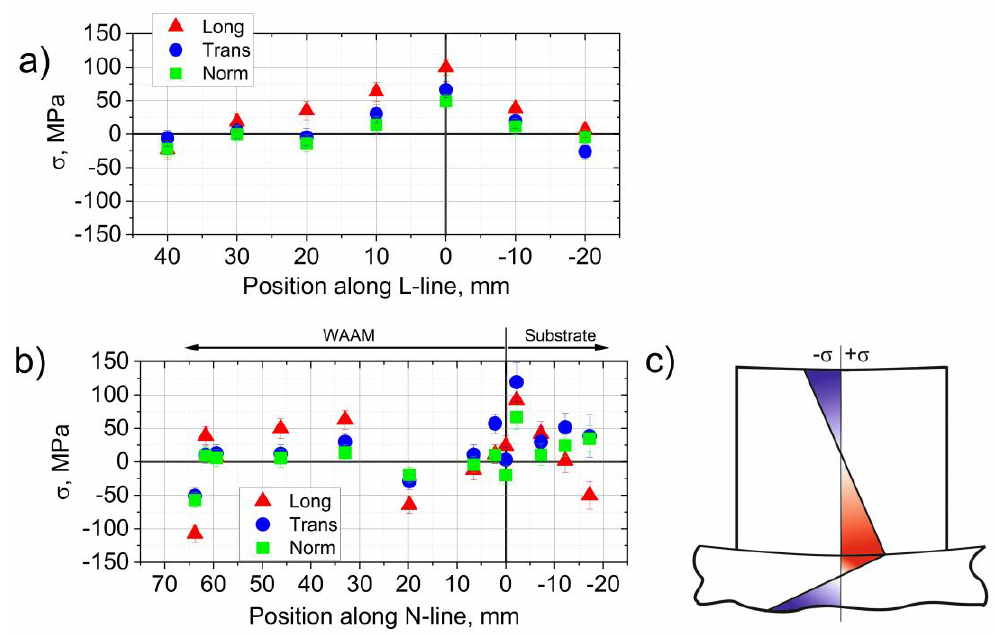
Figure 12. RS profile ( a ) along the L-line and ( b ) along the N-line, ( c ) schematic of the typical stress profile along the WAAM sample height.